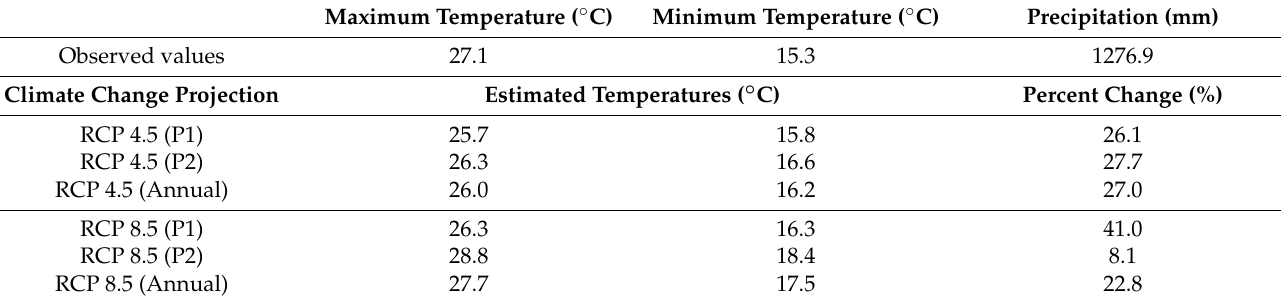
Table 4. Percentage change in average, minimum, and maximum daily temperatures and the average annual precipitation for future climate projection scenarios compared to current climate scenario (2012 to 2019). P1 corresponds to the average for the years 2020 to 2053; P2 corresponds to the average for the years 2054 to 2095; “Annual” corresponds to the average for the entire projection period (2020 to 2095).